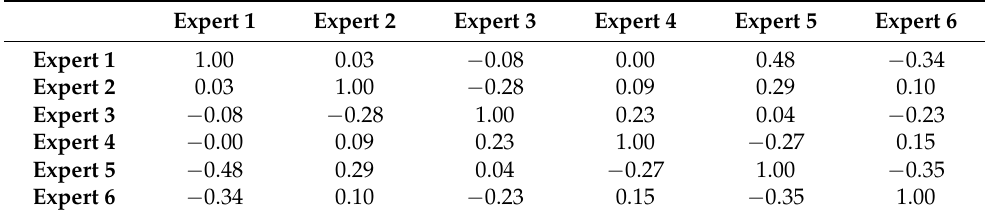
Table A4. Similarity index matrix of the experts for the